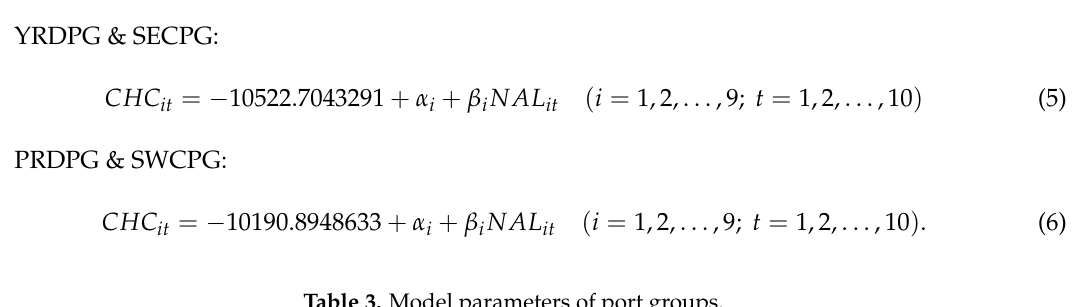
Table 3. Model parameters of port groups.